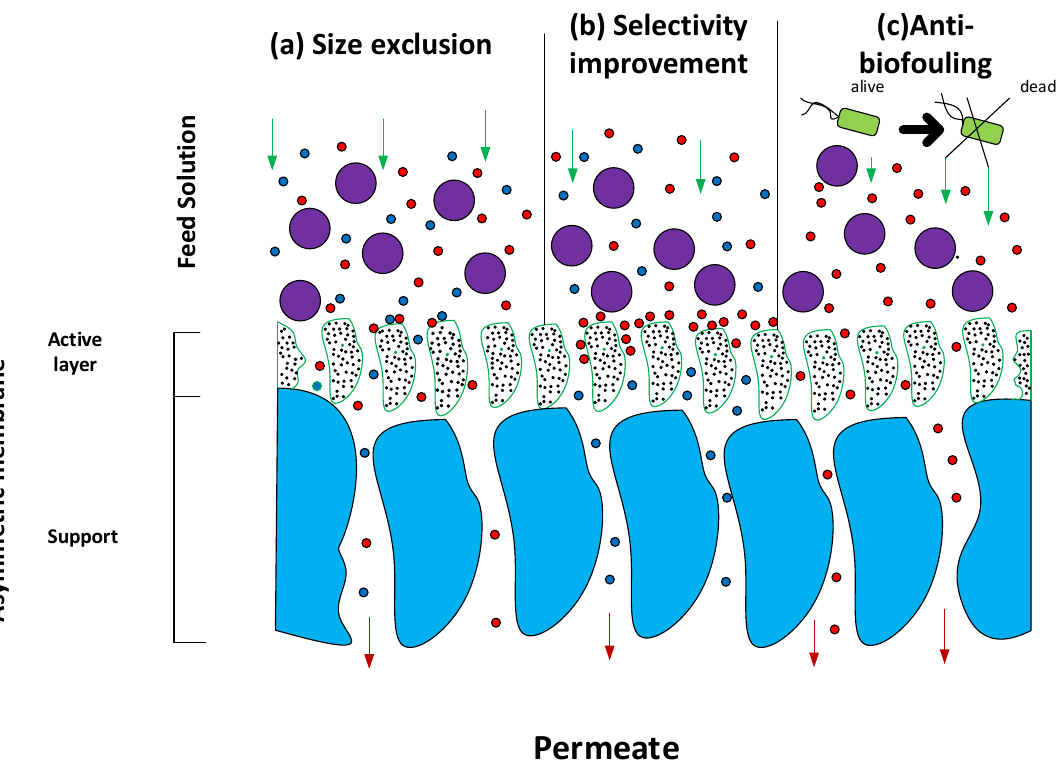
Figure 10. ( a ) A schematic of a nanocomposite asymmetric membrane that does not affect separation mechanisms; ( b ) an improvement in selectivity due to the interaction of a surface nanomaterial with a particular solute; ( c ) an improvement in functionality due to the presence of anti-biofouling properties.